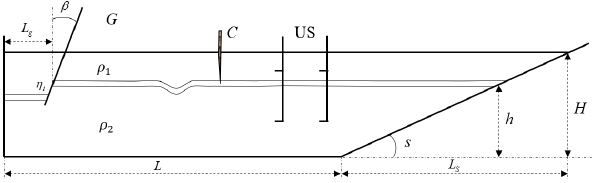
Figure 12. Schematic diagram of the laboratory set-up.“ C ” and “US” represent the experimental devices at the